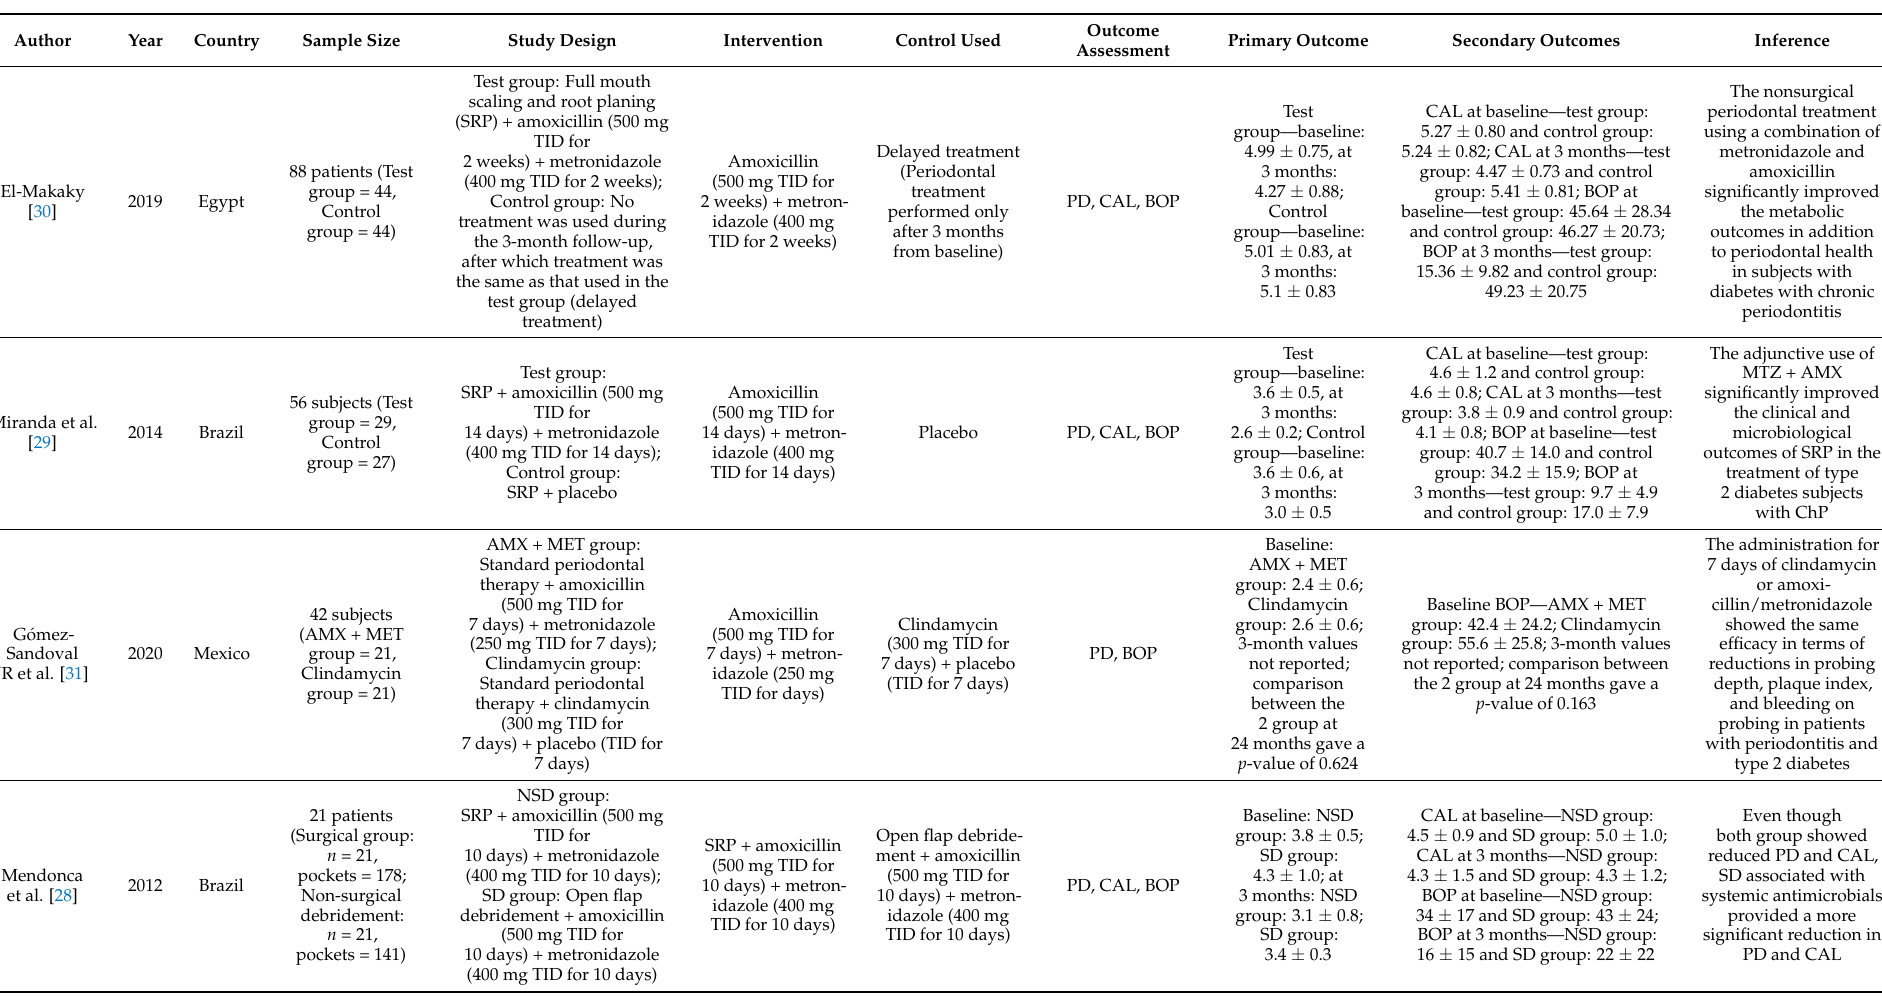
Table 1. Characteristics of the selected